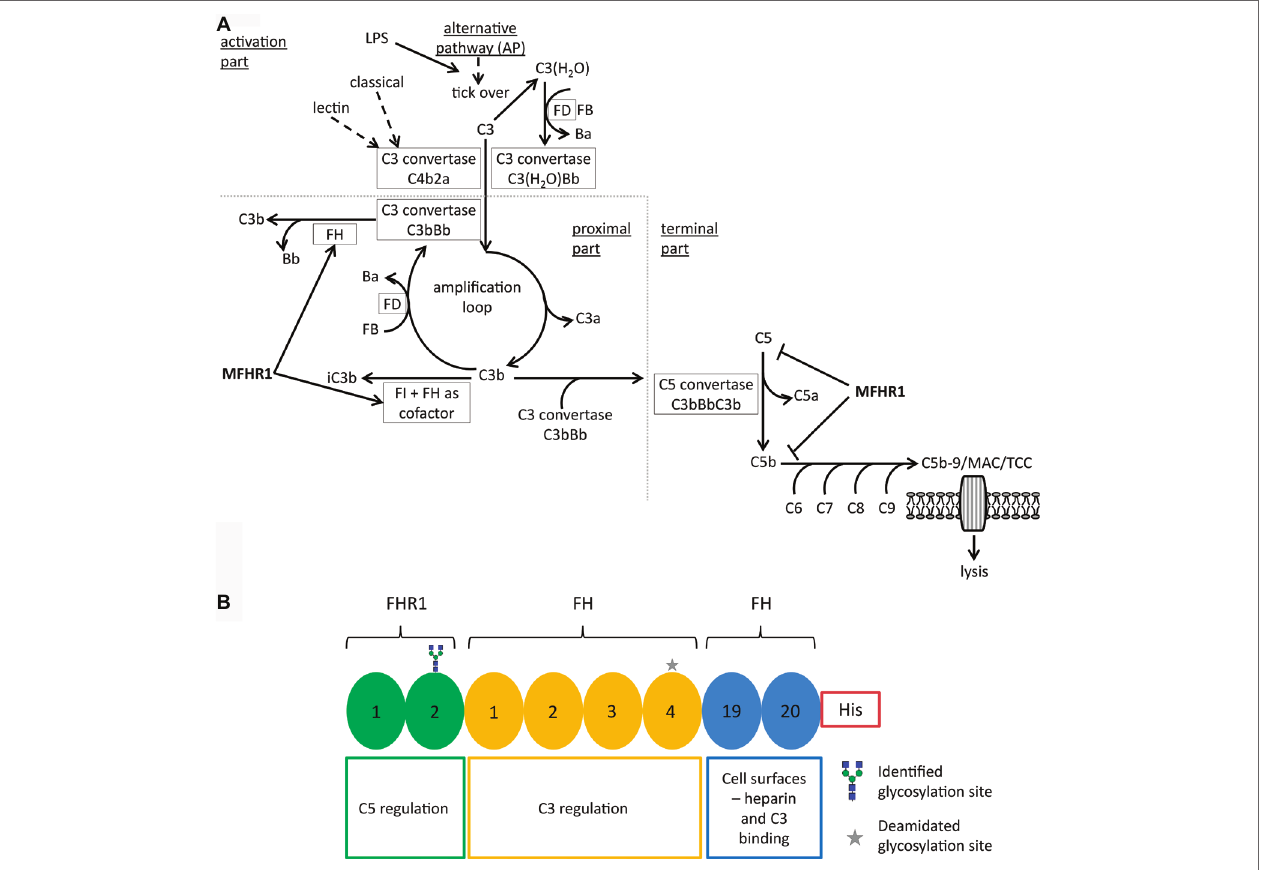
FIGURE 1 | Schematic representation of MFHR1 activity mechanism and structure. (A) MFHR1 regulates the alternative pathway simultaneously at different stages. Processes promoted by MFHR1 or activated by lipopolysaccharide (LPS) are marked by arrows and the step inhibited by MFHR1 is marked by a blocking arrow. F: complement regulatory factor, C: complement component, a or b: cleavage fragments, iC3b: inhibited C3b, AP: alternative pathway, LPS: lipopolysaccharide, MAC: membrane attack complex, TCC: terminal complement complex. (B) The synthetic MFHR1 protein comprises eight short consensus repeats (SCR), namely FHR1 1-2 , FH 1-4 and FH 19-20 , without artificial linkers and an 8x histidine tag at the C-terminus